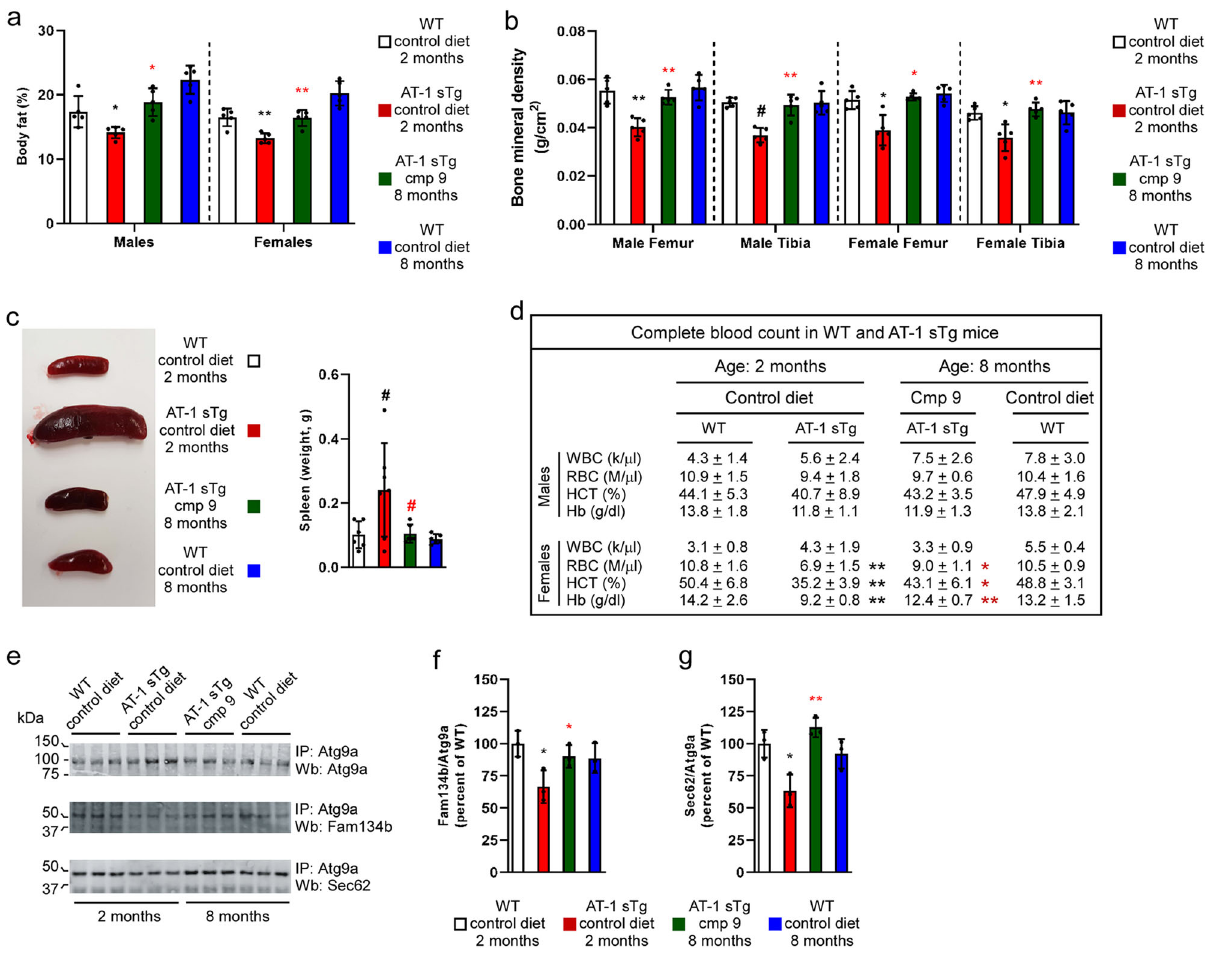
Fig. 2 Late treatment with Compound 9 rescues the AT-1 sTg phenotype. a Quanti fi cation of body fat. b Quanti fi cation of bone mineral density. c Representative image of spleens (left panel) and quanti fi cation (right panel). d Hematologic parameters of WT mice and AT-1 sTg mice (WT (2 month), n = 5; WT (8 month), n = 5; AT-1 sTg (control diet), n = 5; AT-1 sTg (cmp 9), n = 5). e – g Western blot showing co ‐ immunoprecipitation of Atg9a, Fam134b, and Sec62 in WT and AT ‐ 1 sTg mice. Representative blots are shown in ( e ) while quantitation of results is shown in ( f , g ). Bars represent mean ± SD. * p < 0.05, ** p < 0.005, # p < 0.0005 via ordinary two-way ANOVA with Tukey ’ s multiple comparison test. Black symbol, signi fi cance vs WT;